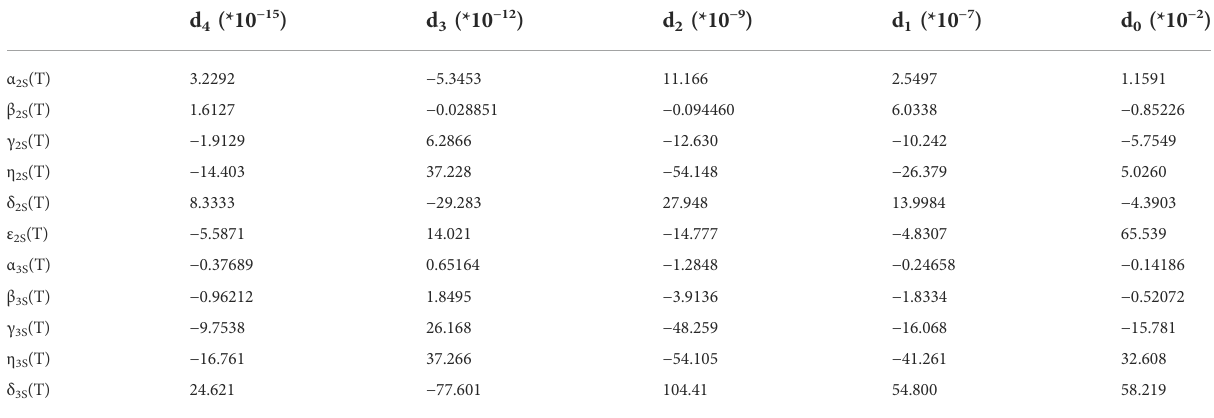
TABLE 5 Fitting parameters for α 2 , 3 , β 2 , 3 , γ 2 , 3 , and δ 2 , 3 under the strained condition.